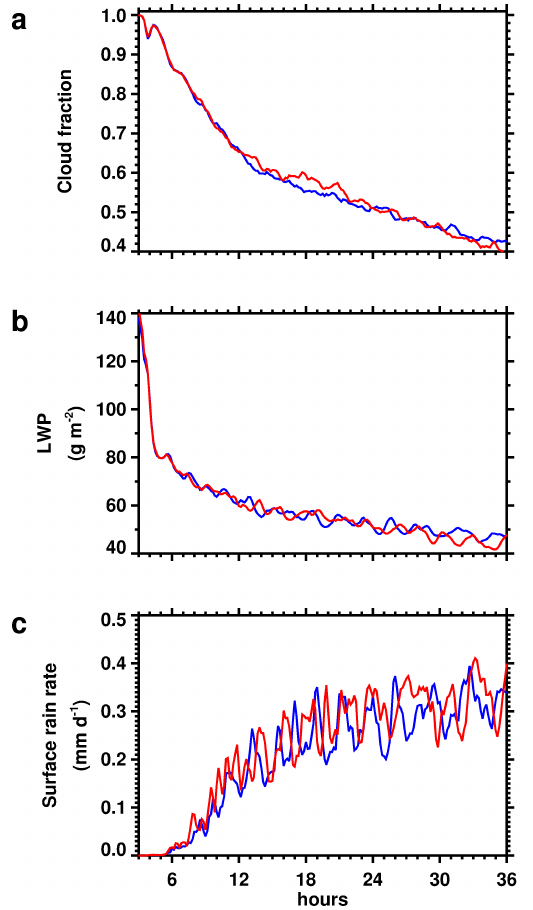
Fig. 18. Domain-averaged time series of selected quantities in sim- ulation S ◦ (blue) and S ¯◦